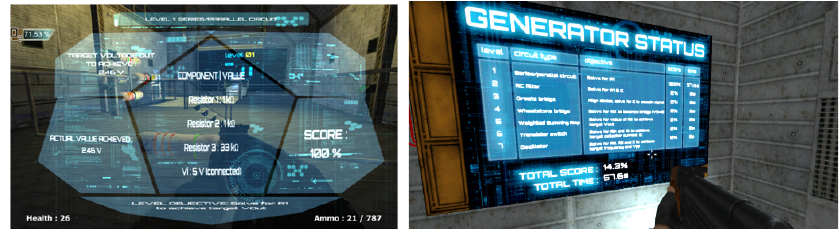
Fig. 11. HUD in game information and generator status